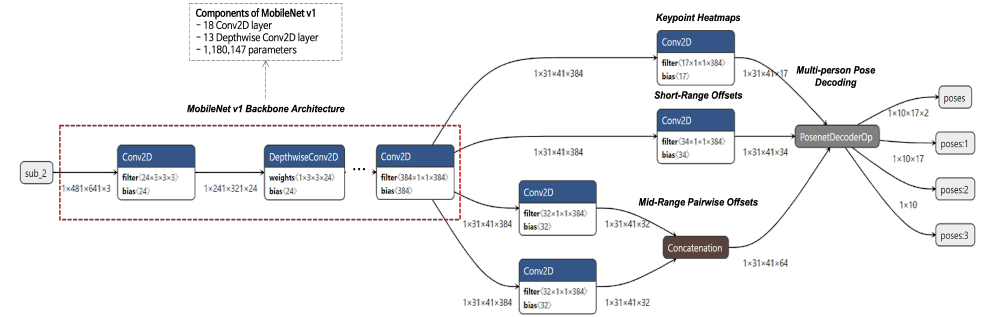
Figure 2. The PoseNet model with the MobileNet v1 backbone